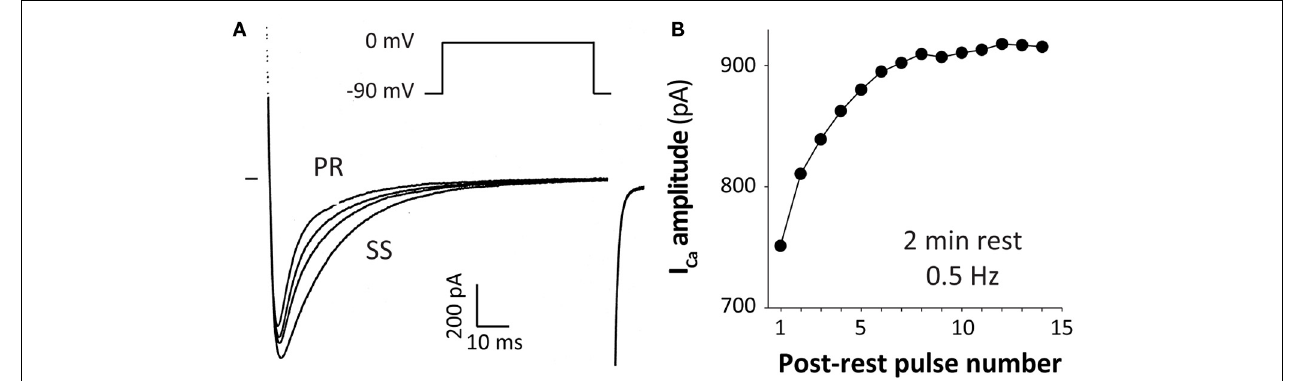
FIGURE 3 | Ca 2 + -dependent facilitation of I Ca . I Ca at 0.5Hz (from − 90 to 0mV) after a 2min rest period in a ferret ventricular myocyte. The first post-rest pulse (PR) and the second, third and steady state (SS)